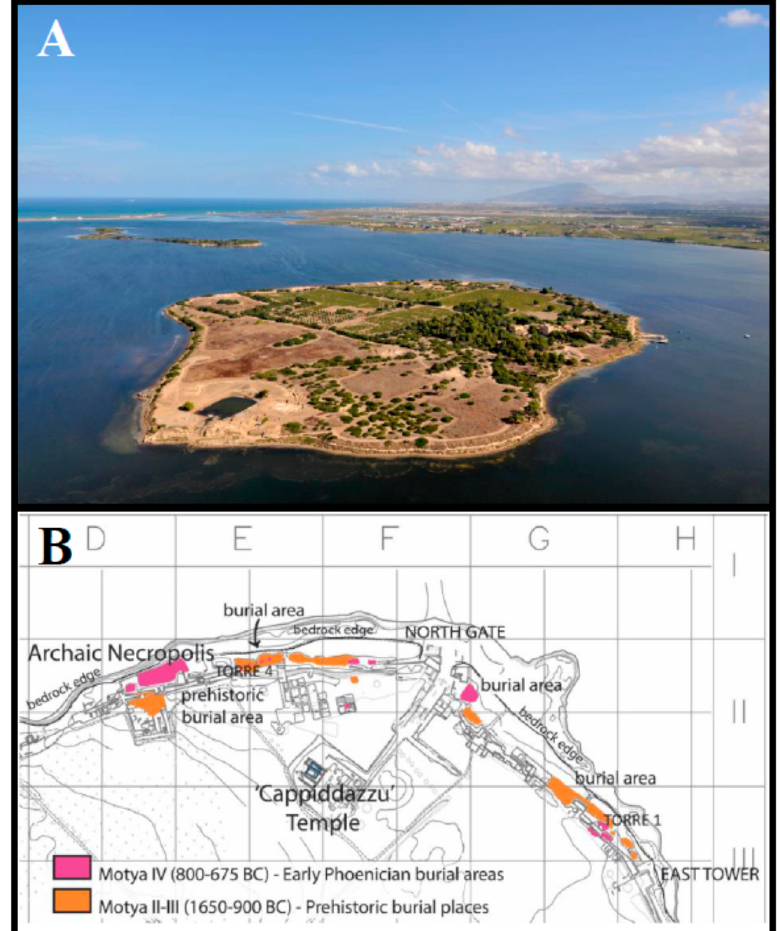
Figure 1. Archaeological site of Motya. ( A ) South view of San Pantaleo island located at the center of the Marsala Lagoon (Trapani, western tip of Sicily, Italy) (archive of Sapienza Archaeological Expedition at Motya); ( B ) Northwestern sector of Motya [34], the Phoenician burial areas were highlighted in pink. Table 1. Micro-remains detected in dental calculus by optical microscopy (OM). Lab code, burial (identification number), sex (M, male; F, female; ND, not determined; IND, indeterminate), age at death (in years) of each individual were specified, together with the weight of dental calculus. The amount of the micro-debris (i.e., starches, pollen grains, and other particles) identified in dental calculus